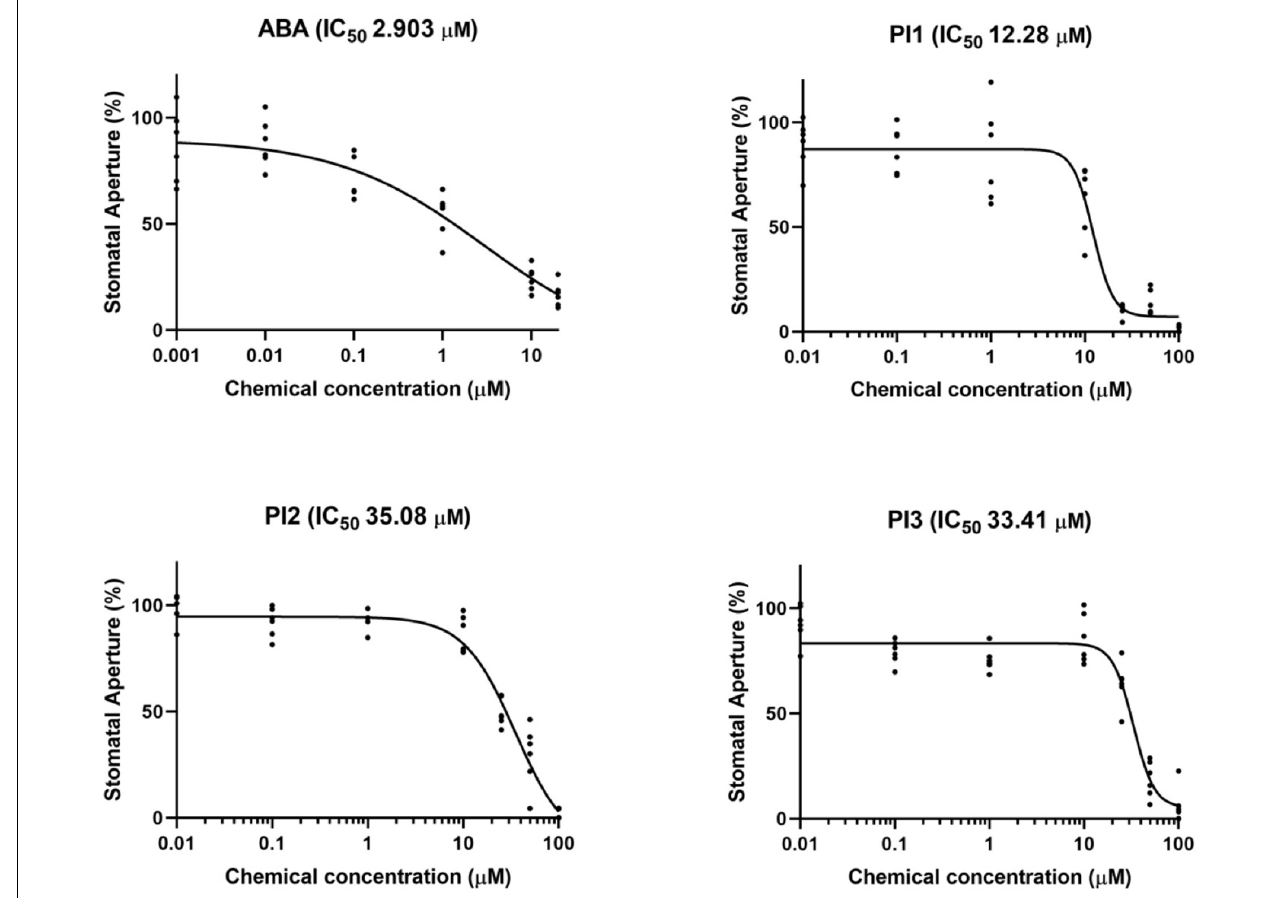
FIGURE 2 | IC 50 curves of ABA, PI1, PI2, and PI3 for light-induced stomatal opening. The concentrations used to obtain IC 50 curves were 0.001, 0.01, 0.1, 1, 10, and 20 µ M for ABA and 0.01, 0.1, 1, 10, 25, 50, and 100 µ M for PIs. IC 50 values were computed by GraphPad Prism ( n = 6, 30 stomata from 3 leaf discs per